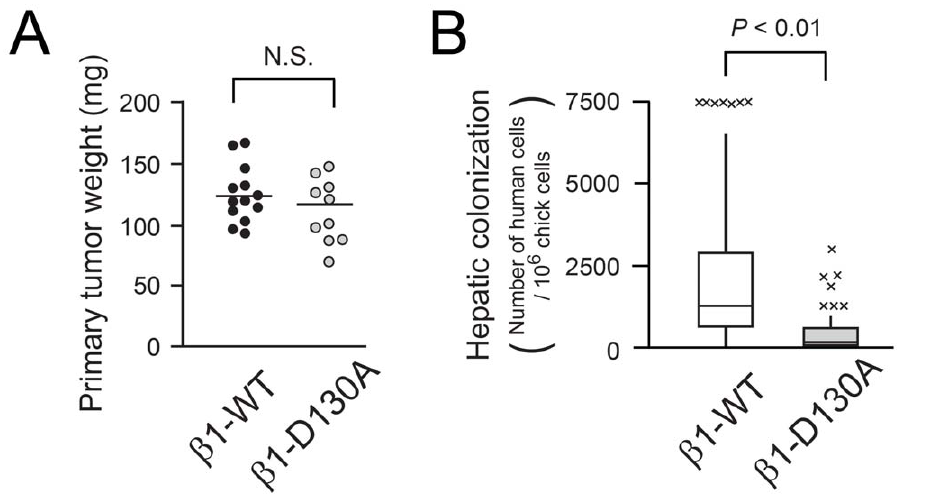
Figure 2. Ligand binding to b 1 integrins is required for hepatic colonization by tumor cells. (A) In vivo tumor growth assay on the chick chorioallantoic membrane. Tumors growing on the membrane were weighed seven days after inoculation of 10 6 b 1-WT (n=13) or b 1-D130A MDA- MB435 cells (n=10). (B) Box plot showing the number of b 1-WT (n=67) and b 1-D130A cells (n=57) quantified in chick embryo livers five days after intravenous tumor cell injection.